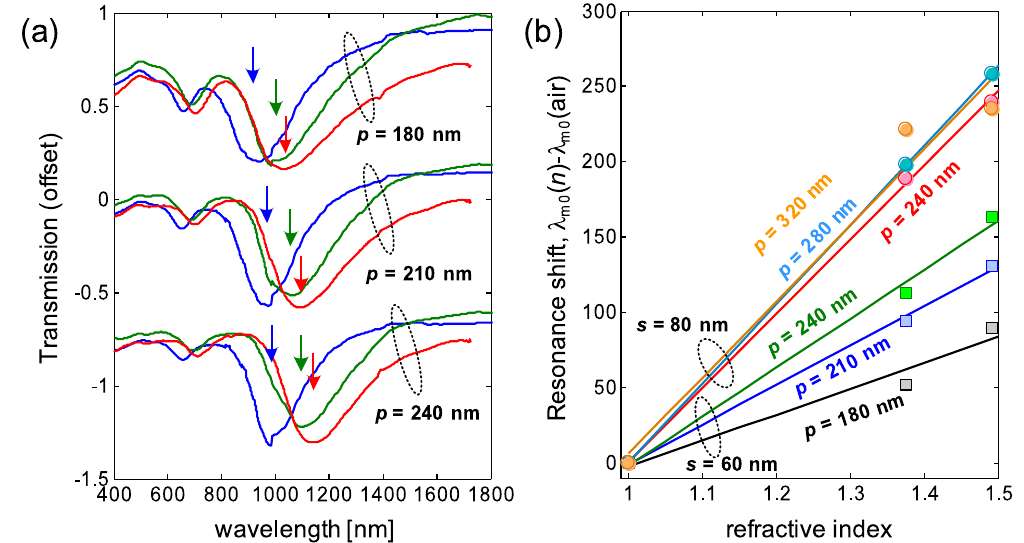
Figure 7. Bulk sensing characteristics of C 4 U-SRR structures. ( a ) Measured transmission spectra of C 4 U-SRRs for s = 60 nm, s = 80 nm, and s = 100 nm under different claddings. The resonance positions for air, isopropyl alcohol solution, and 100-nm thick PMMA are indicated by the blue, green, and red arrows, respectively. ( b ) The C 4 U-SRR bulk sensitivities for different resonator sizes.